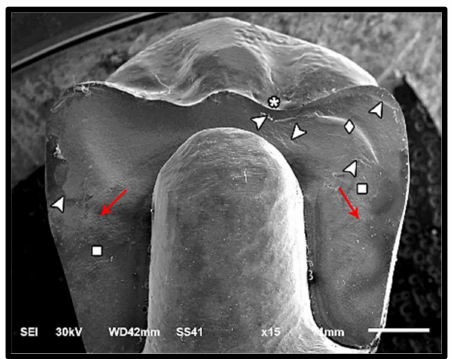
Figure 9. SEM micrograph represents class II failure mode of zirconia fractured specimen showing fracture origins (asterisk) at the loading occlusal surface, hackle lines (square) indicating the direction of crack propagation (red arrow), compression curl (diamond) indicating the crack propagation ends and begins in another direction before total fracture, and diffused arrest lines (arrow-head) through the fractured restoration.